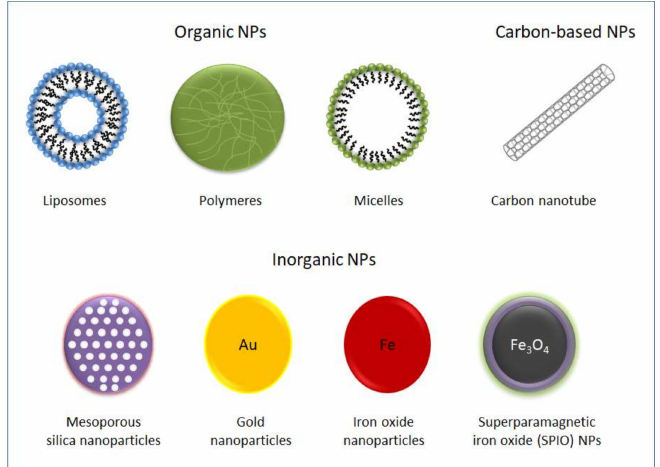
Figure 1. Types of nanoparticles commonly used for biomedical